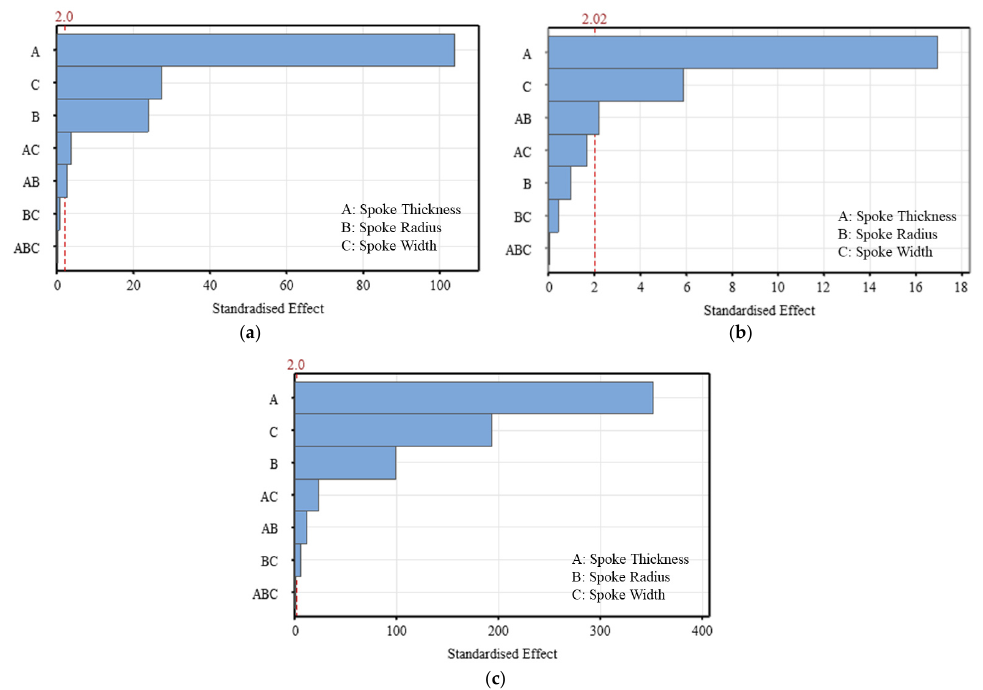
Figure 15. Pareto chart for ( a ) vertical stiffness; ( b ) longitudinal stiffness; and ( c ) weight.